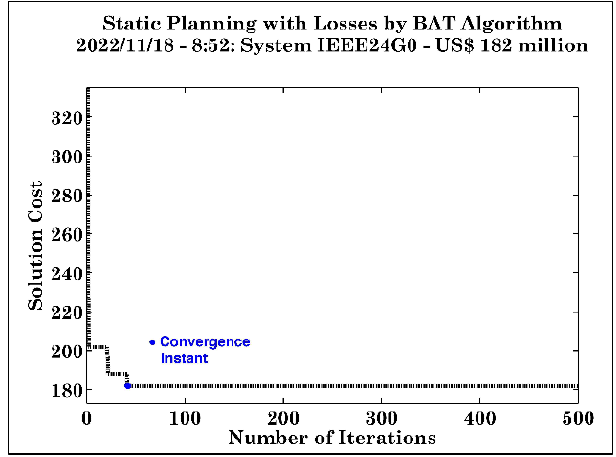
Figure 5: Case WR - IEEE-24/41 test system. Cost convergence curve. Source: BATp optimizer, (2022).